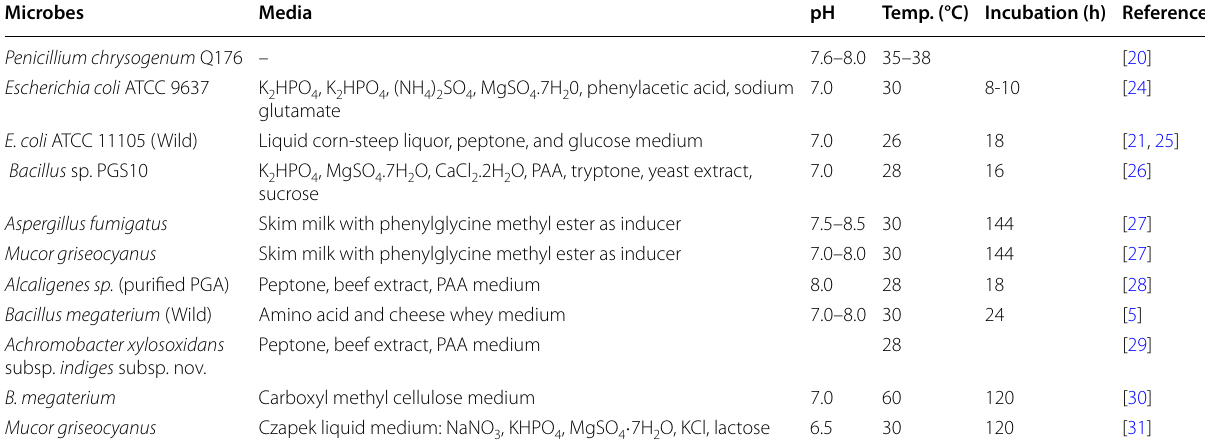
Table 1 Production kinetics of PGA producing wild type strains Microbes Media Penicillium chrysogenum Q176 –